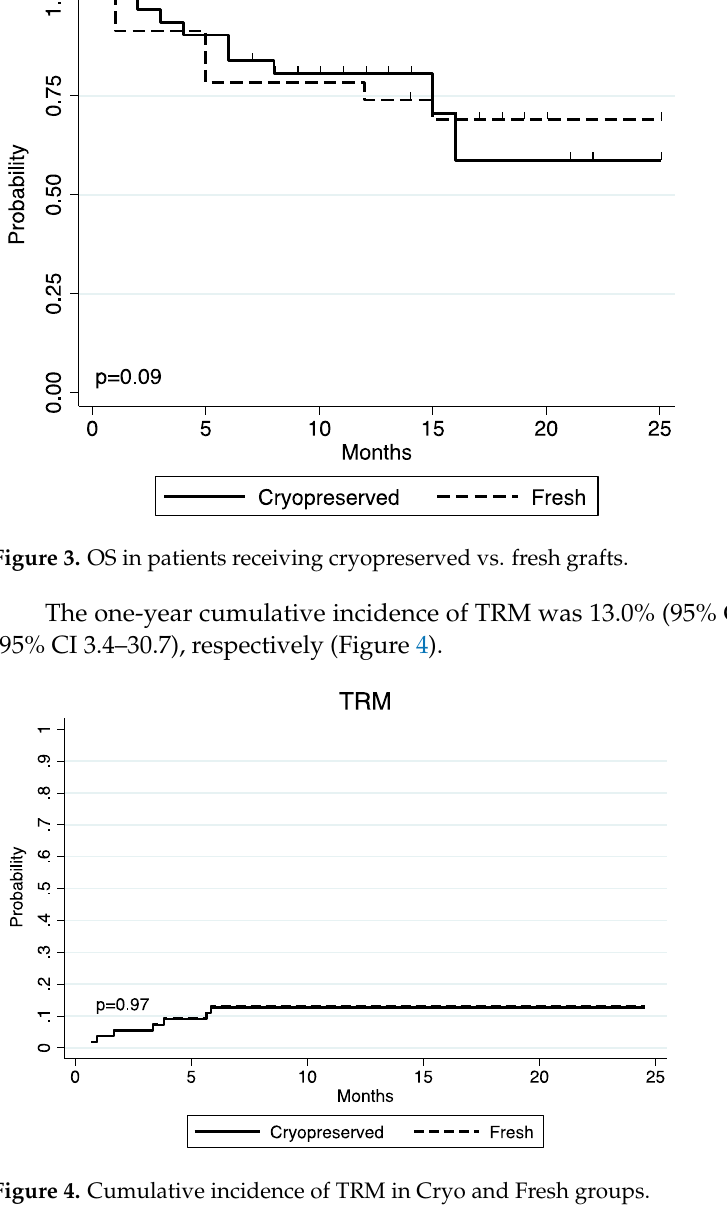
Figure 2. PFS in patients receiving cryopreserved vs. fresh grafts.